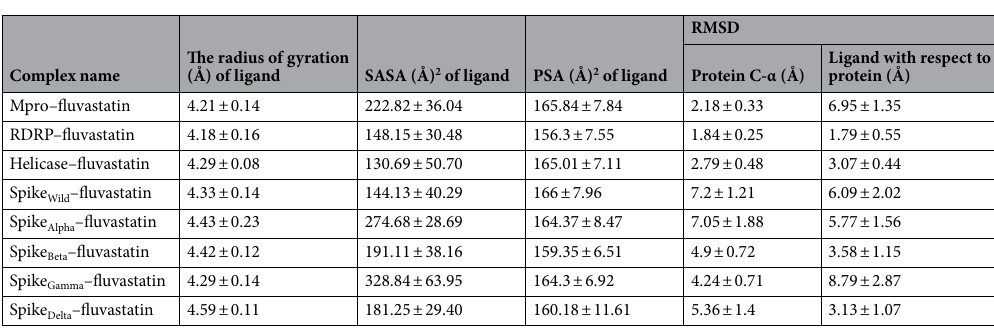
Table 6. Molecular dynamics analysis of fluvastatin-target protein